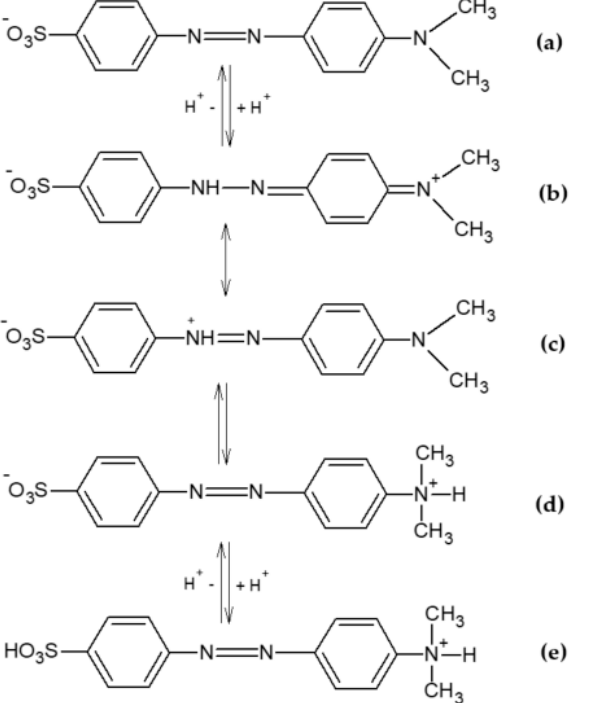
Figure 7. Different MO structures: ( a ) alkaline, ( b − d ) zwitterionic and its tautmer, and ( e ) acidic.